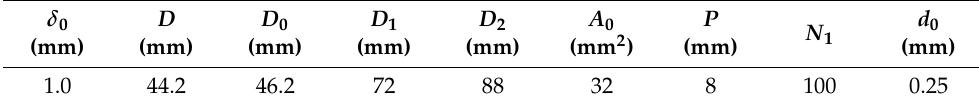
Table 1. Structural parameters of the self-inductive displacement sensor.